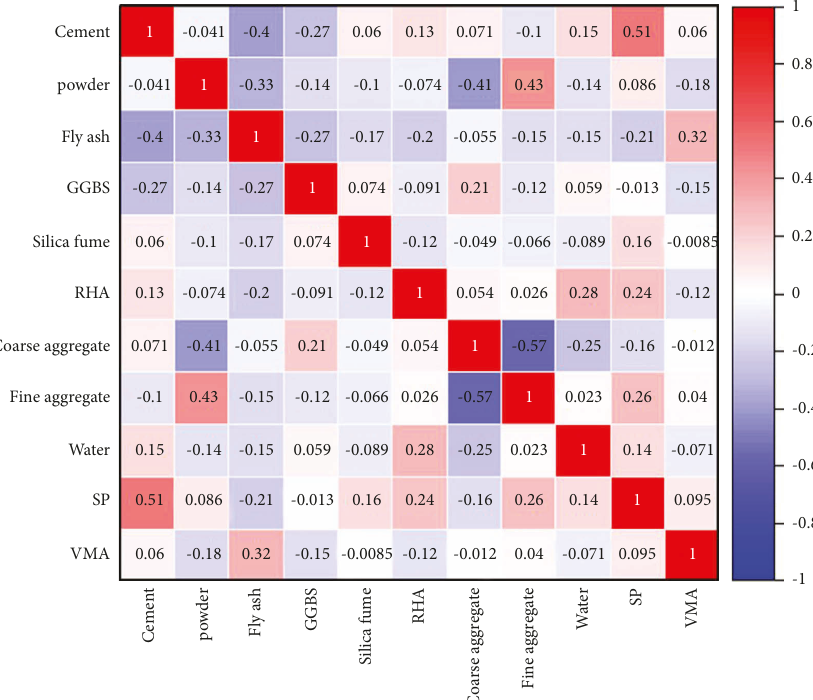
Figure 4: Correlation matrix of experimental